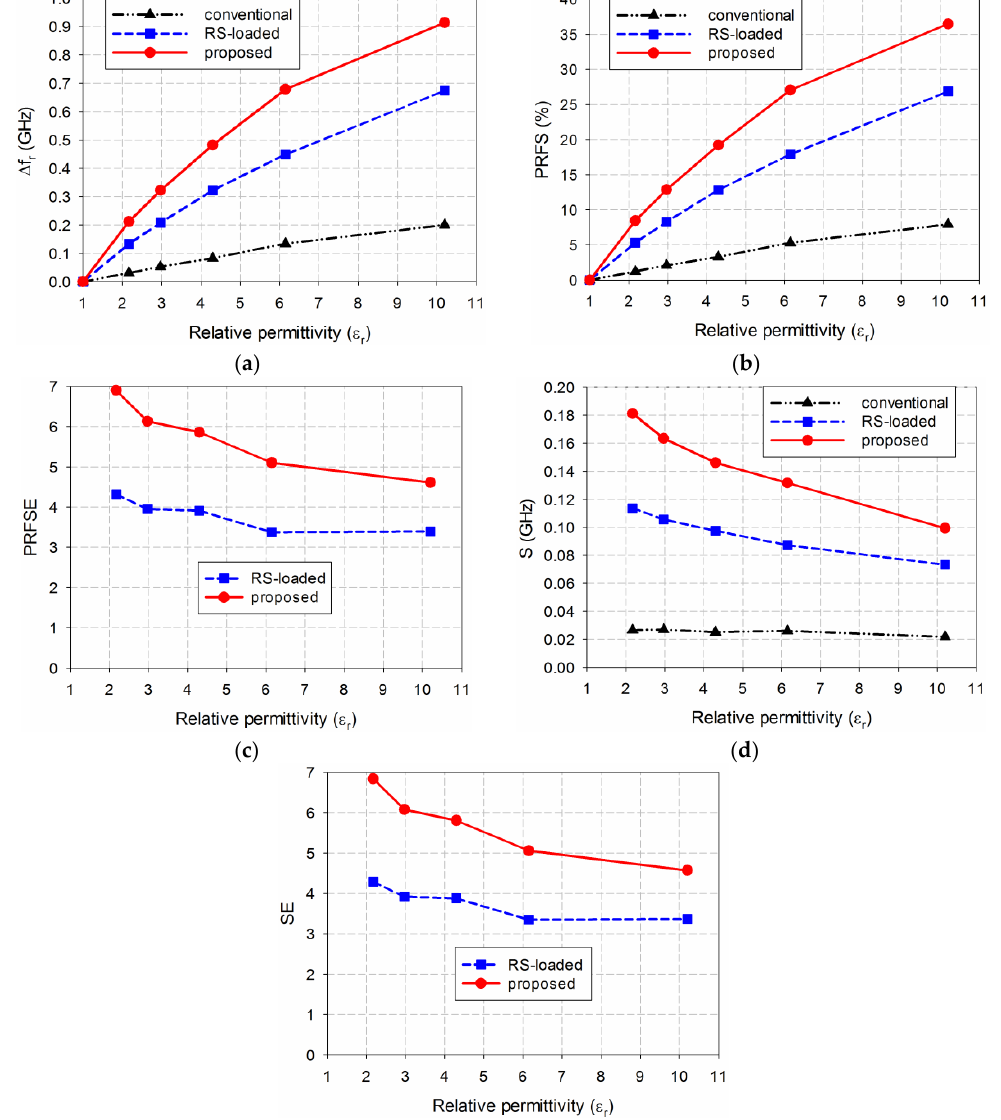
Figure 12. Measured sensitivity comparison of the three MPSAs for the MUTs in Table 2: ( a ) Δ f r ; ( b ) PRFS; ( c ) PRFSE; ( d ) S; and ( e ) SE.